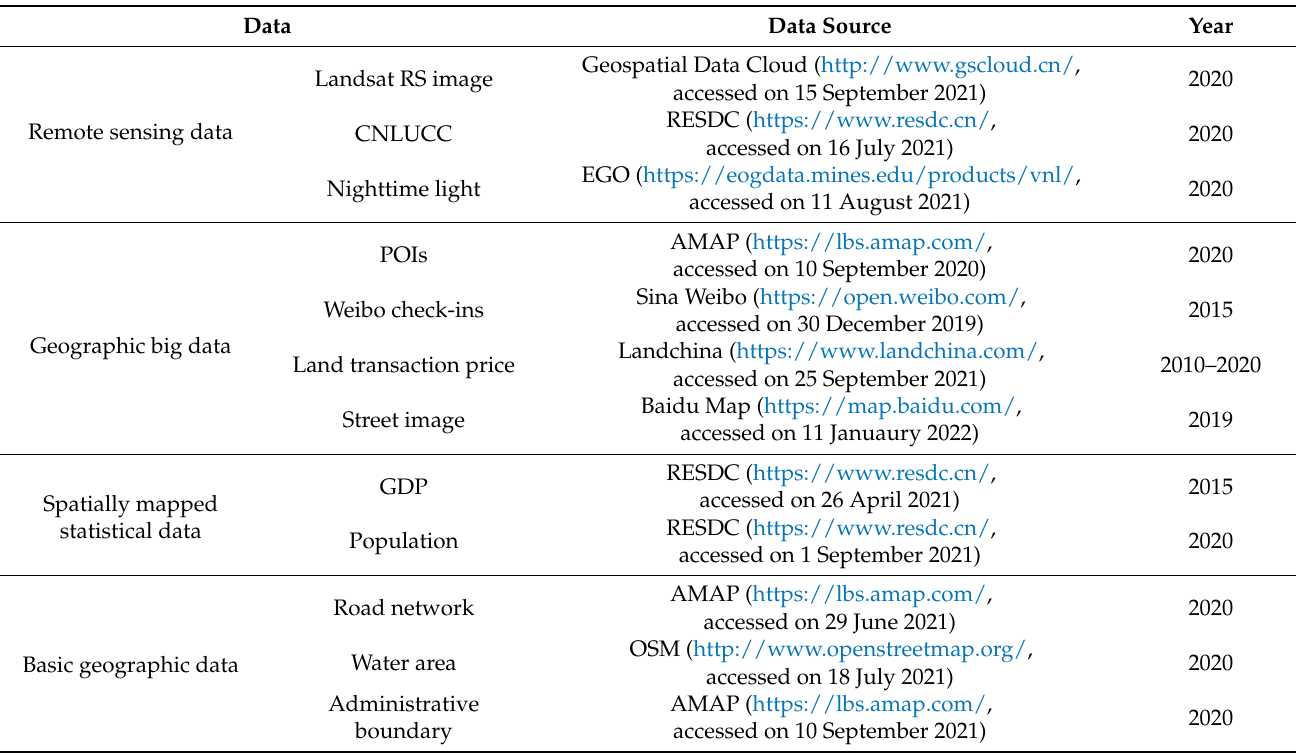
Figure 3. Study area. Table 1. Data sources used in this